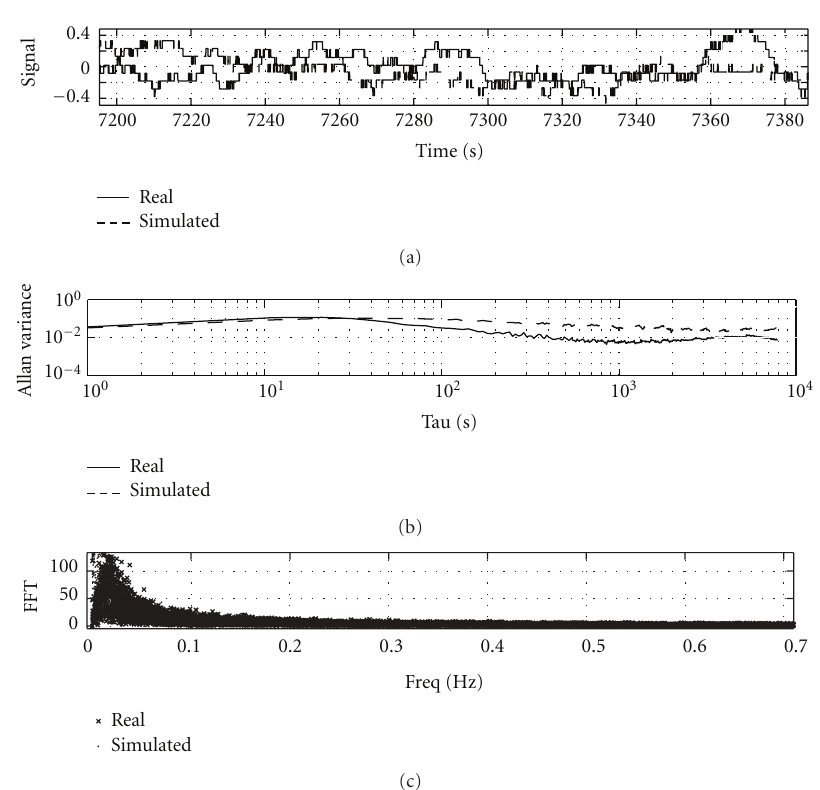
Figure 8: Comparative results for real and simulated IMU sensor error for Pitch angle. (a) Window of the time series (degrees). (b) Allan variance plot (degrees). (c) FFT of time series (degrees 2